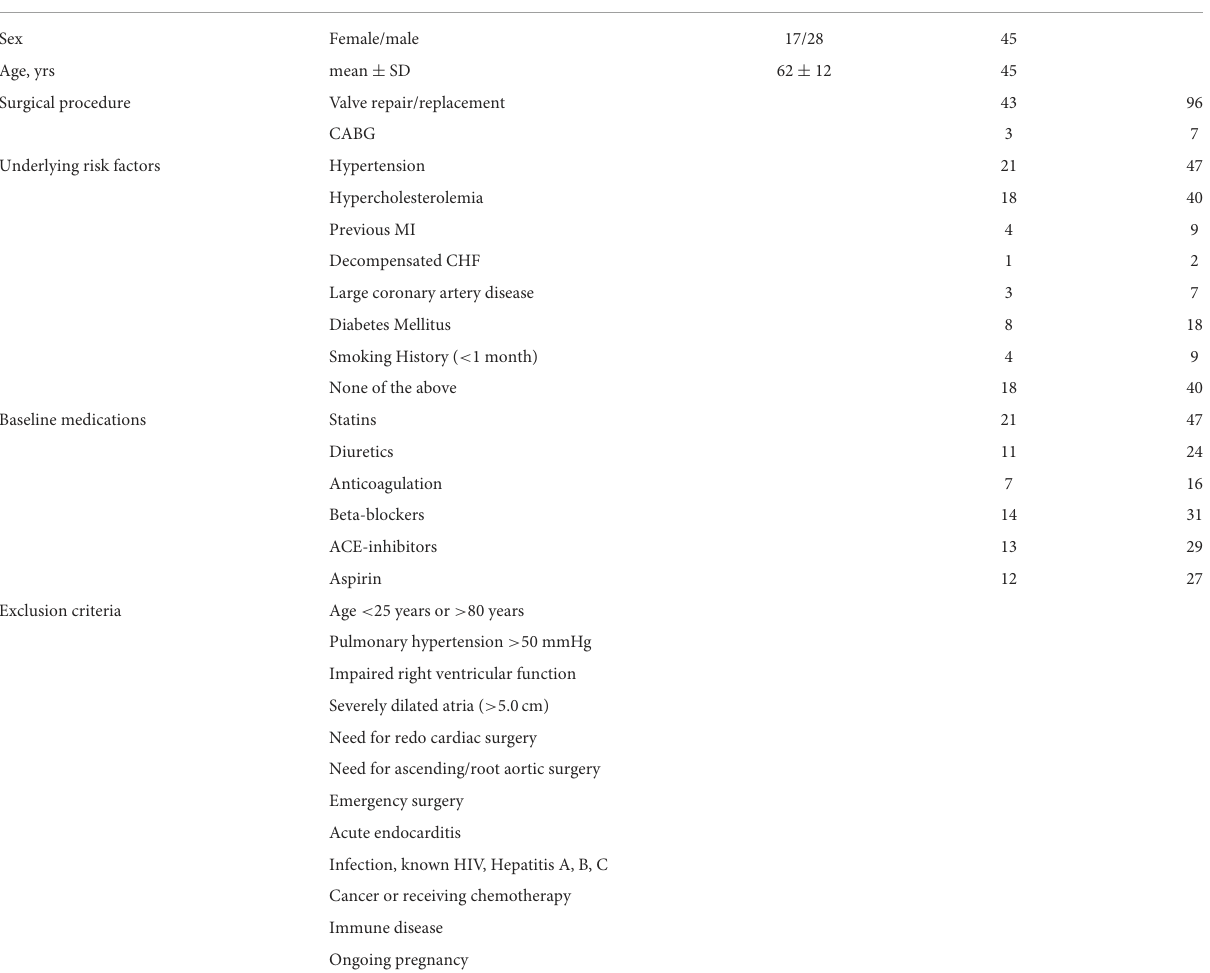
TABLE 1 Patient demographics and exclusion criteria ( n = 45) *